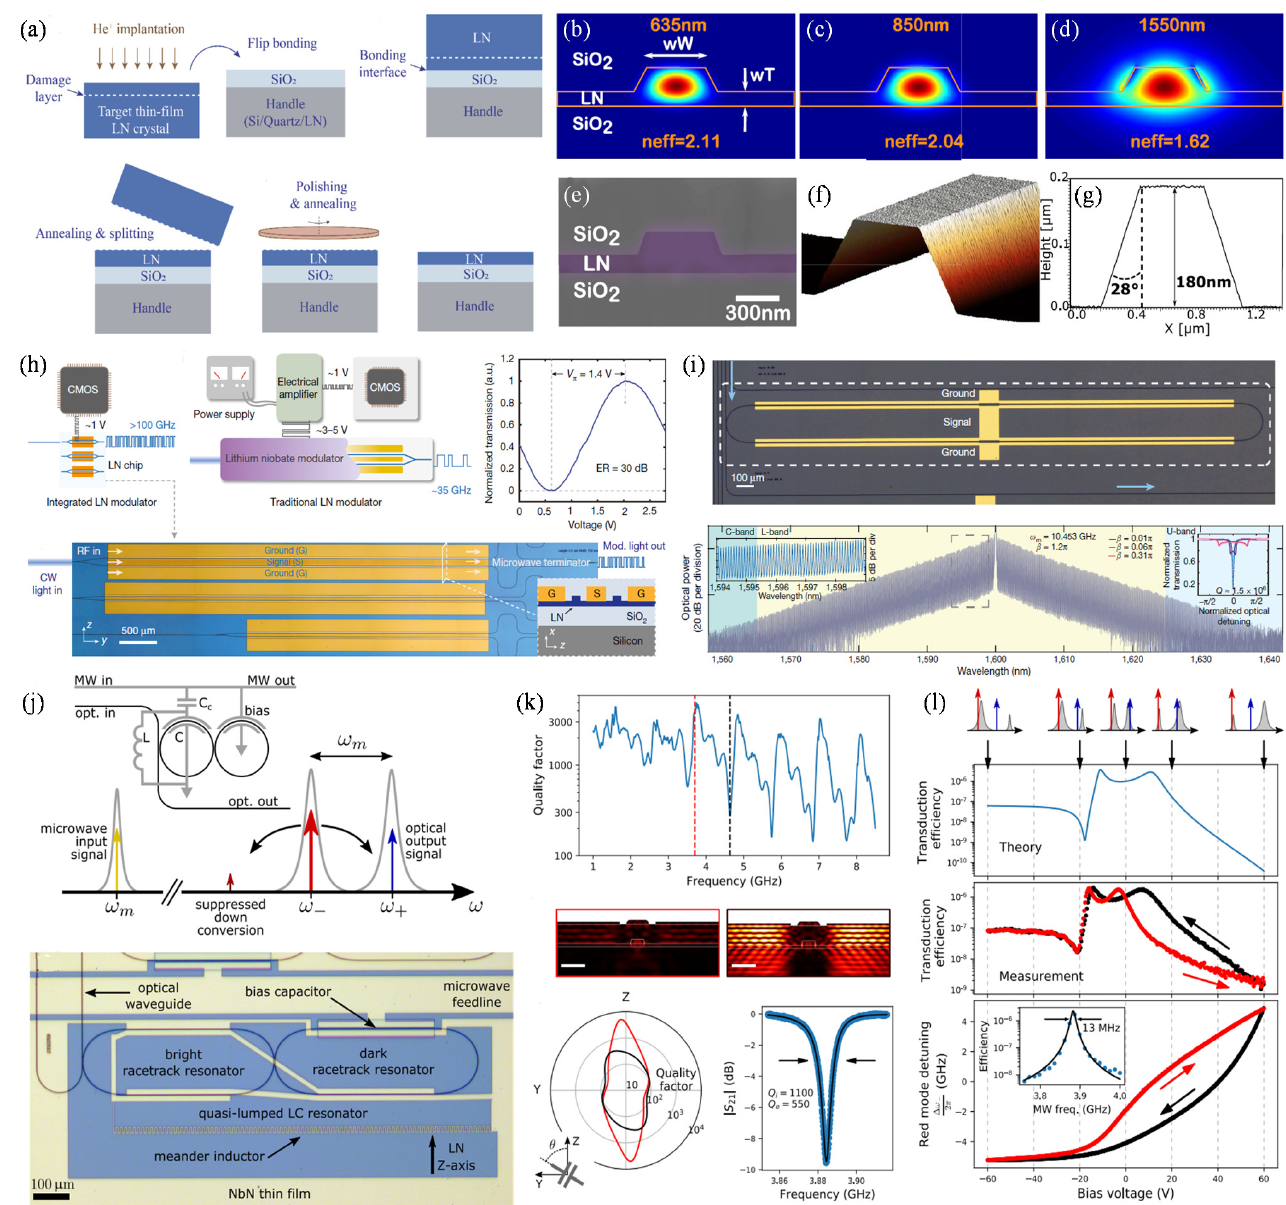
Figure 6. LiNbO 3 thin-film transfer for high-performance electro-optical modulators. ( a ) Schematic diagram of the LiNbO 3 thin-film transfer for the fabrication of LNOI wafer [148]. ( b – d ) Finite element simulation of the TE 00 waveguide mode near the wavelengths of 635 nm, 850 nm, and 1550 nm [22]. ( e ) SEM image of the cross-sectional waveguide [22]. ( f ) and ( g ) Surface morphology and surface profile of the LiNbO 3 waveguide [22]. ( h ) Schematic diagram and optical images of the nanophotonics LiNbO 3 modulator compatible with CMOS drive voltages [21]. ( i ) Optical image of the fabricated LiNbO 3 -based comb generator [20]. ( j ) Schematic diagram and optical image of the designed superconducting cavity electro-optic transducer based on the LNOI platform [149]. ( k ) Performance test of the piezoelectric loss in LiNbO 3 [149]. ( l ) Performance measurements for the detuning dependence of microwave-to-optical photon transduction [149]. Reprinted with permission from ref. [148]. Copyright 2020 World Scientific. Reprinted with permission from ref. [22]. Copyright 2019. The Optical Society. Reprinted with permission from ref. [21]. Copyright 2018 Springer Nature. Reprinted with permission from ref. [20]. Copyright 2019 Springer Nature. Reprinted with permission from ref. [149]. Copyright 2020 The Optical